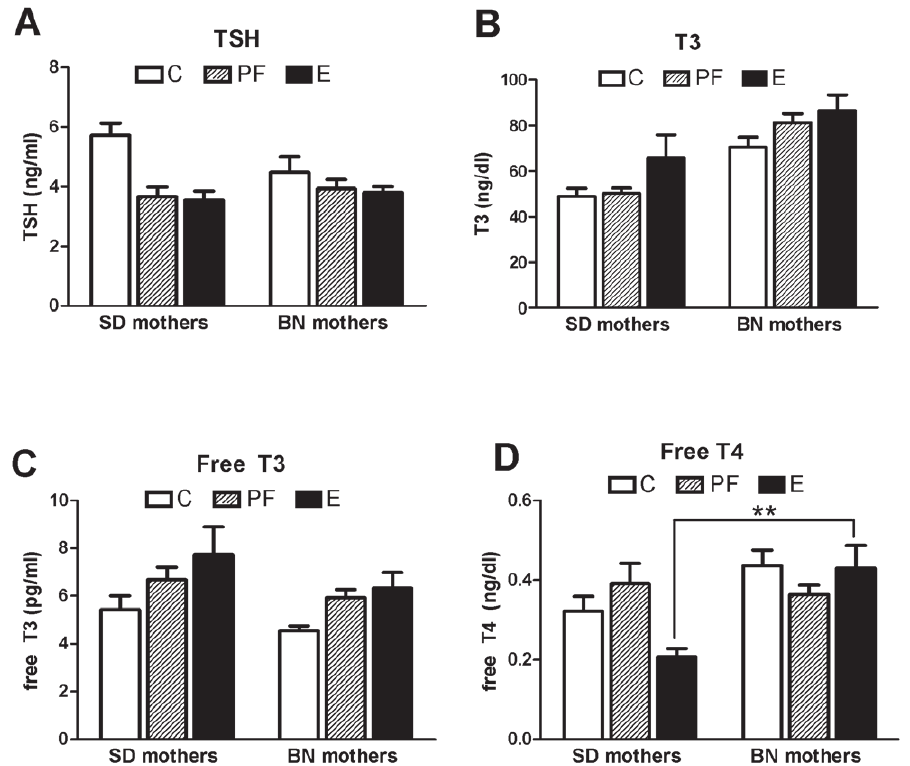
Figure 1. Pregnant SD and BN dams exhibit different susceptibility to alcohol in their thyroid function. (A) Plasma TSH, (B) total T3, (C) free T3 and (D) free T4 levels in control (C), pair-fed (PF), and ethanol-consuming (E) mothers on gestational day 21 (G21). SD mothers include those mated to SD or BN males; BN mothers include those mated to SD or BN males. Alcohol-containing and calorie-restricted diets suppressed plasma TSH levels (F [2, 57]=9.3, P , 0.01) and increased T3 (F [2, 58]=4.0, P =0.02) and fT3 (F [2, 49]=5.6, P , 0.01) levels. Plasma fT4 was decreased by alcohol consumption in SD but not BN mothers (F [2, 56]=5.5, P , 0.01). Plasma T3 levels (F [1, 58]=28.0, P , 0.001) and fT4 (F [1, 56]=11.1, P , 0.01) were higher in BN mothers than SD mothers while fT3 levels were lower in BN (F [1, 49]=4.1, P , 0.05). All data (means {plus minus} SEM) were analyzed by two-way ANOVAs and Bonferroni post-hoc results are shown (** P , 0.01). doi:10.1371/journal.pone.0010058.g001 bodyweight after pair-feeding (maternal strain x paternal strain x diet: F [2, 71] = 5.6, P , 0.01).